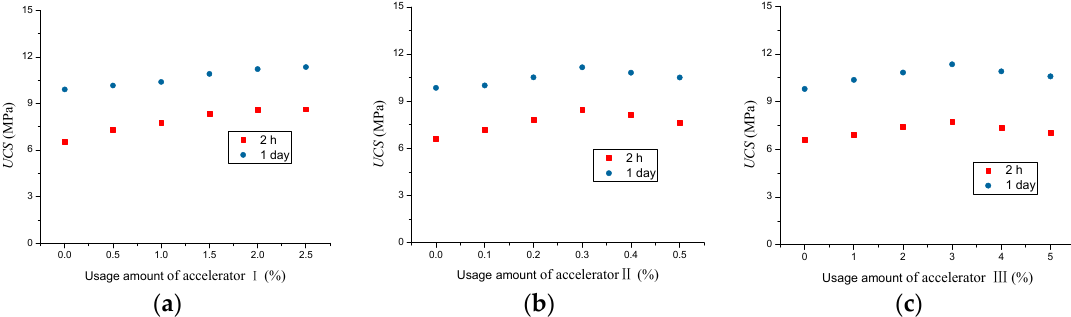
Figure 6. Uniaxial compressive strength (UCS) of grouting materials under different usage amounts: ( a ) accelerator I; ( b ) accelerator II; and, ( c ) accelerator III.